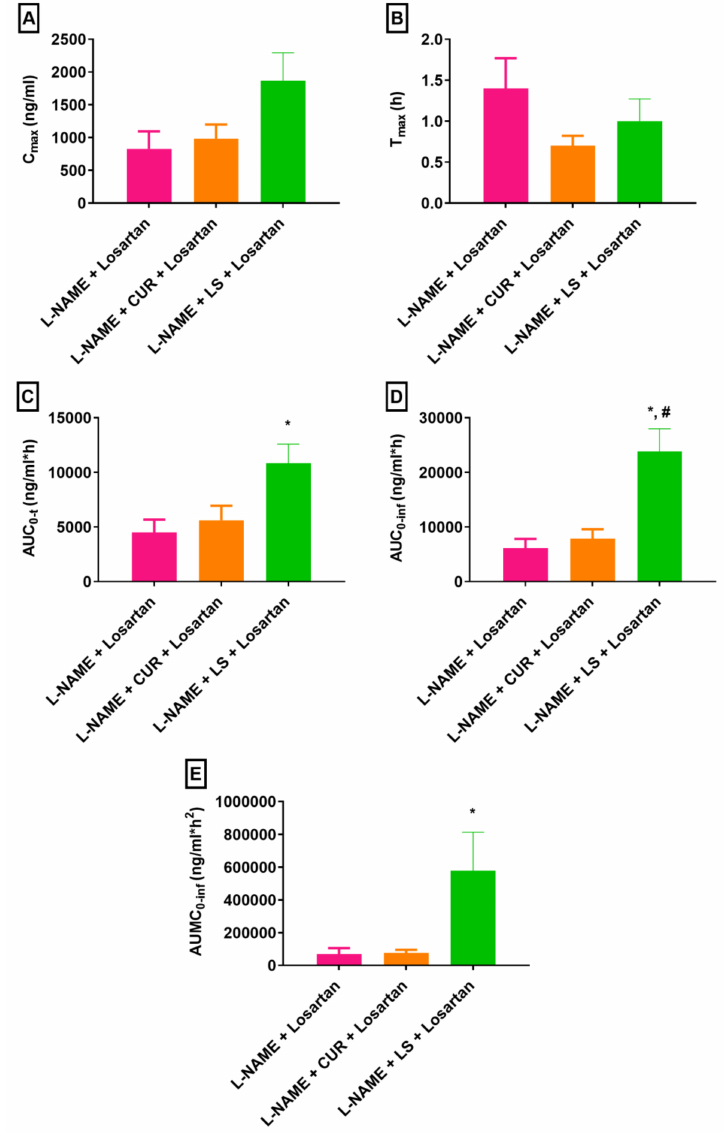
Figure 4. Pharmacokinetic parameters ( A ) C max , ( B ) T max , ( C ) AUC 0-t , ( D ) AUC 0-inf and ( E ) AUMC 0-inf of losartan alone and in presence of CUR and LS following an oral administra- tion in hypertensive rats ( n = 5. mean ± SEM). L-NAME, “N-nitro l-arginine methyl ester”; CUR, Curcuma longa ; LS, Lepidium sativum . * p < 0.05 as compared to L-NAME + losartan, # p < 0.05 as compared to L-NAME + CUR+